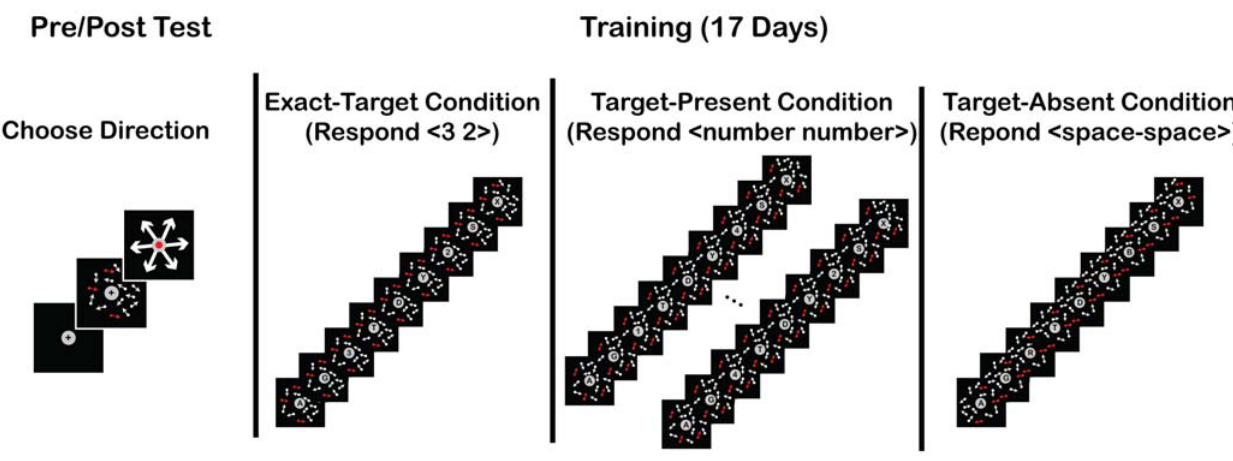
Figure 1. Design of Experiment. Tests, subjects conducted tests before and after training in which they reported the direction of motion coherence by selecting an arrow with a computer mouse. Training, a given trial was from one of three conditions; in the exact-target condition the targets were always the same for a given subject (here , 3 2 . ), in the target-present trials the targets could be any number combination other than that presented in the exact-target condition, and in the target-absent condition no target was presented were to respond , space-space . . Red arrows indicate direction of coherence; a different direction of motion coherences was paired with each trial type.